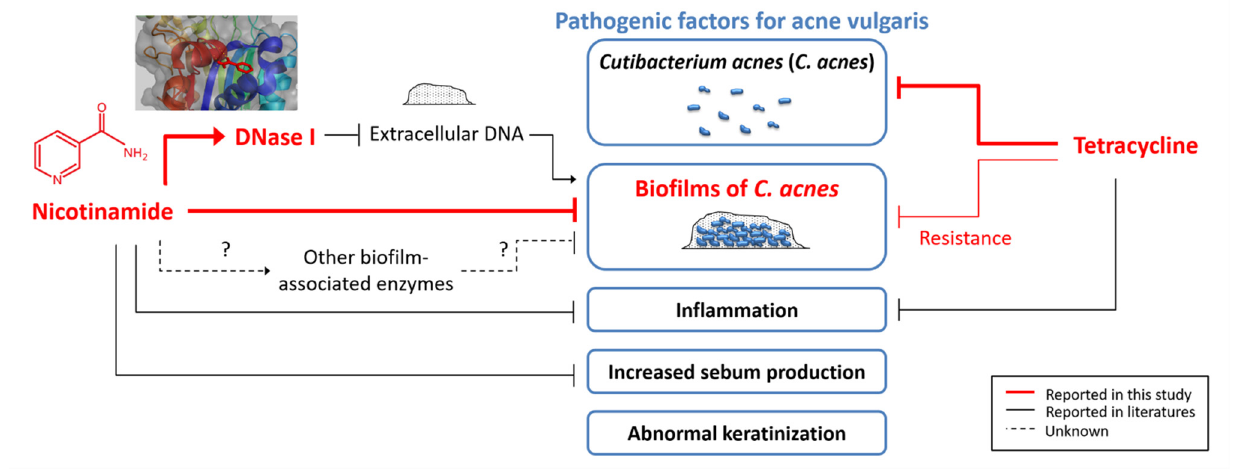
Figure 7. Diagram summarizing the mechanism of action of nicotinamide (NAM) in acne vulgaris.